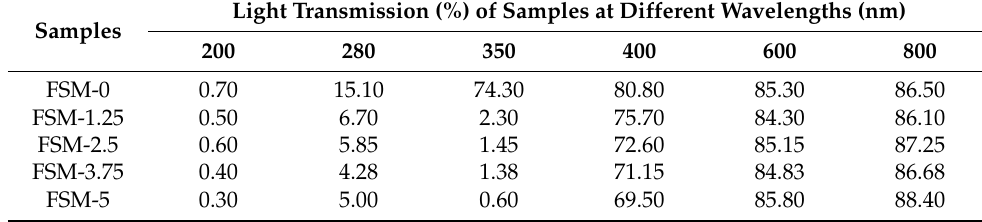
Table 3. Light transmission of composite edible